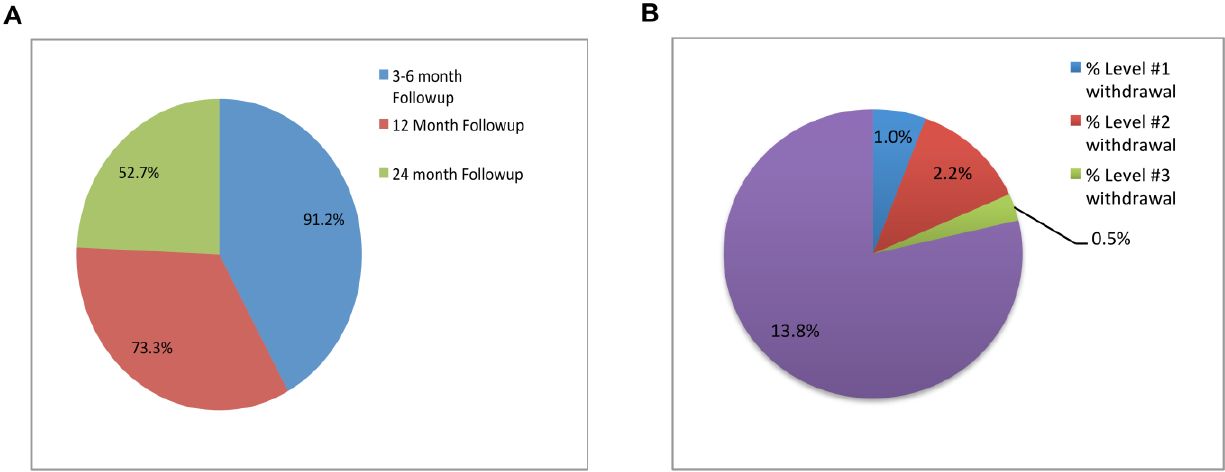
Figure 4. ( A ) The percentage of Cancer 2015 patients with at least one follow-up, binned into time periods 3–6, 12 and 24 months post-registration into phase 1 of the study; ( B ) Percentage of Cancer 2015 patients that have either deceased or withdrawn consent to the study as of end of phase 1 (level 1 = no contact but patient approves continuation of collecting data, level 2 = no contact but patient requests to stop collecting data, level 3 = no contact and patient requests removal of data and destruction of